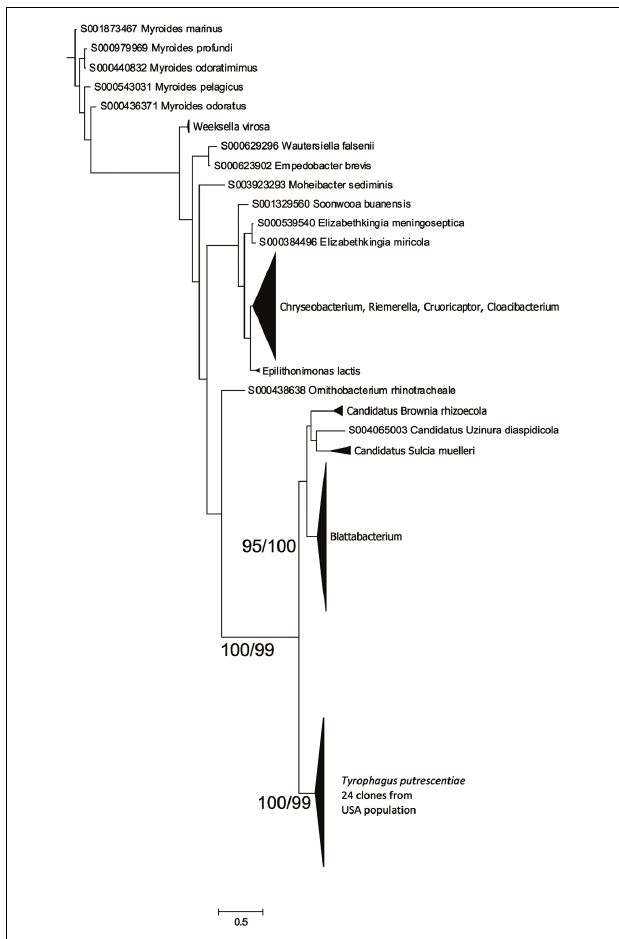
FIGURE 3 | Phylogenetic analysis of the Blattabacterium -like symbiont clones obtained from the Dog population of T. putrescentiae. The phylogeny was inferred by a Bayesian analysis of 24 partial 16S rRNA gene sequences with the reference sequences from RDP, i.e., 126 sequences of Blattabacterium , C. Brownia, and C. Sulcia, and the sequences of 398 type strains representing the order Flavobacteriales . Branch lengths correspond to the mean posterior estimates of evolutionary distances (scale bar: 0.5). Branch labels indicate Bayesian posterior probabilities and bootstrap support values from maximum likelihood analysis. The phylogram was rooted using Bacteroides fragilis sequence NR074784 as an